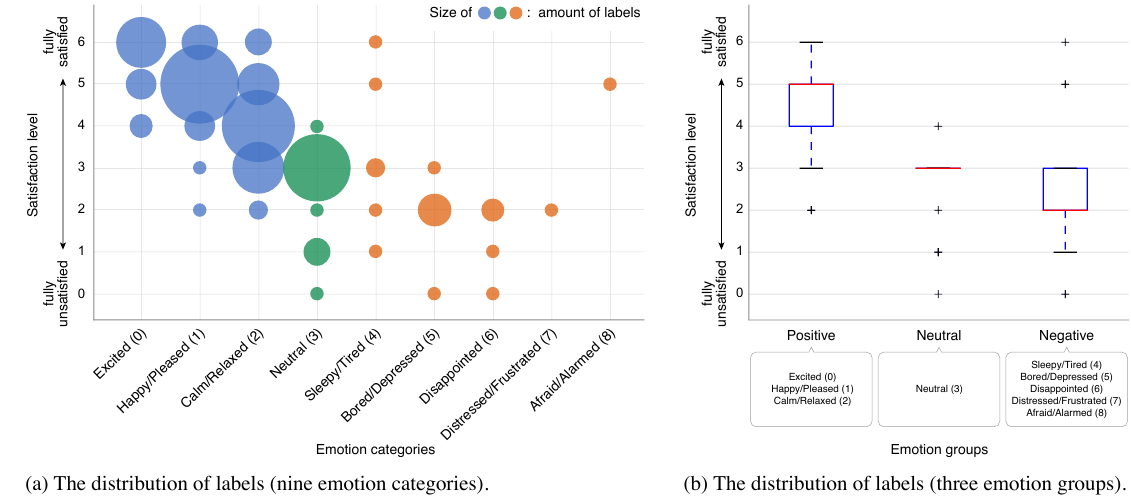
Figure 10. Relationship between emotional status and satisfaction